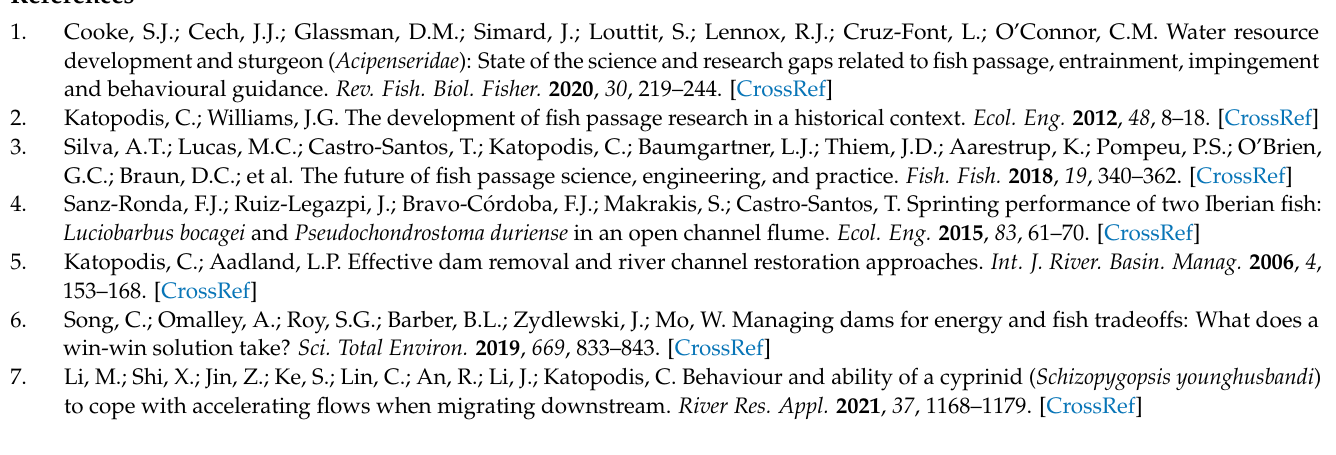
Figure S2: Three-dimensional velocity vector; Figure S3: Comparison of the measurement and simulation flow velocity (m/s) results. The dashed line represents 20% error; Figure S4: On-site photos of experiment; Table S1: Swimming speed (m/s ± SD) and ascent time (s) for each fish ( n = 60) under different